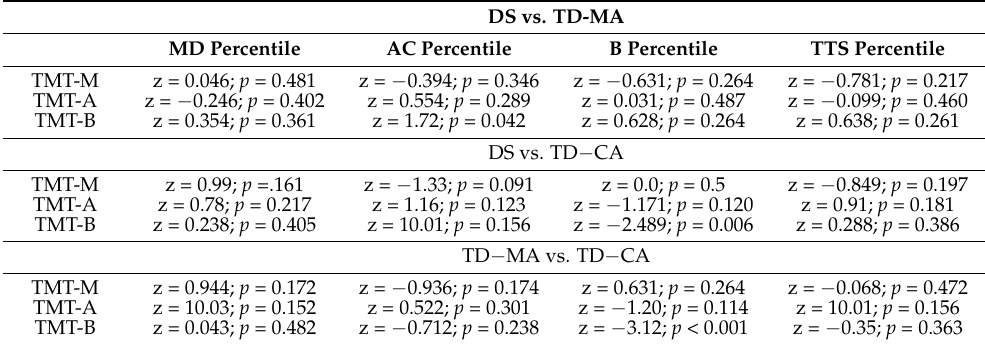
Table 3. Differences in magnitude of correlations (Fisher’s z) across cognitive (Trail-Making Test) and motor (Movement Assessment Battery for Children-2) indices for the sample of TD-MA ( n = 12), TD-CA ( n = 12) and children with DS ( n = 12) controlled for sports participation and sex. DS vs.